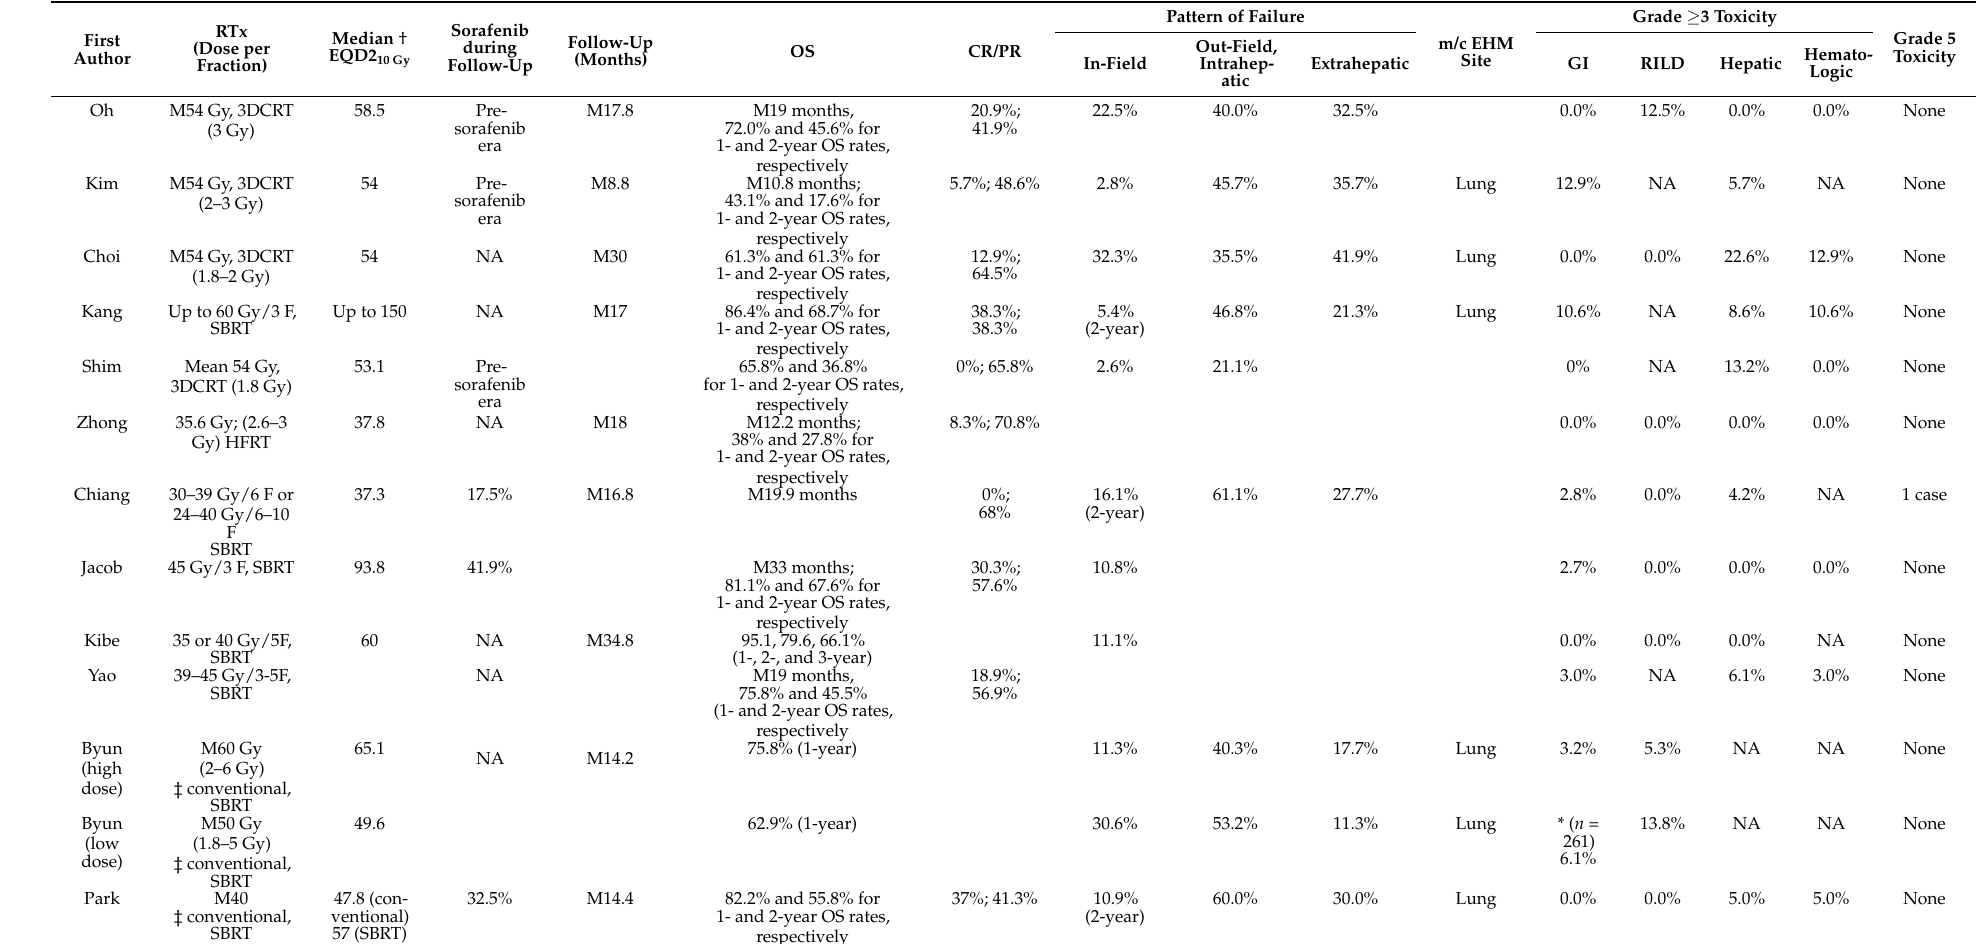
Table 2. Clinical outcomes of the included